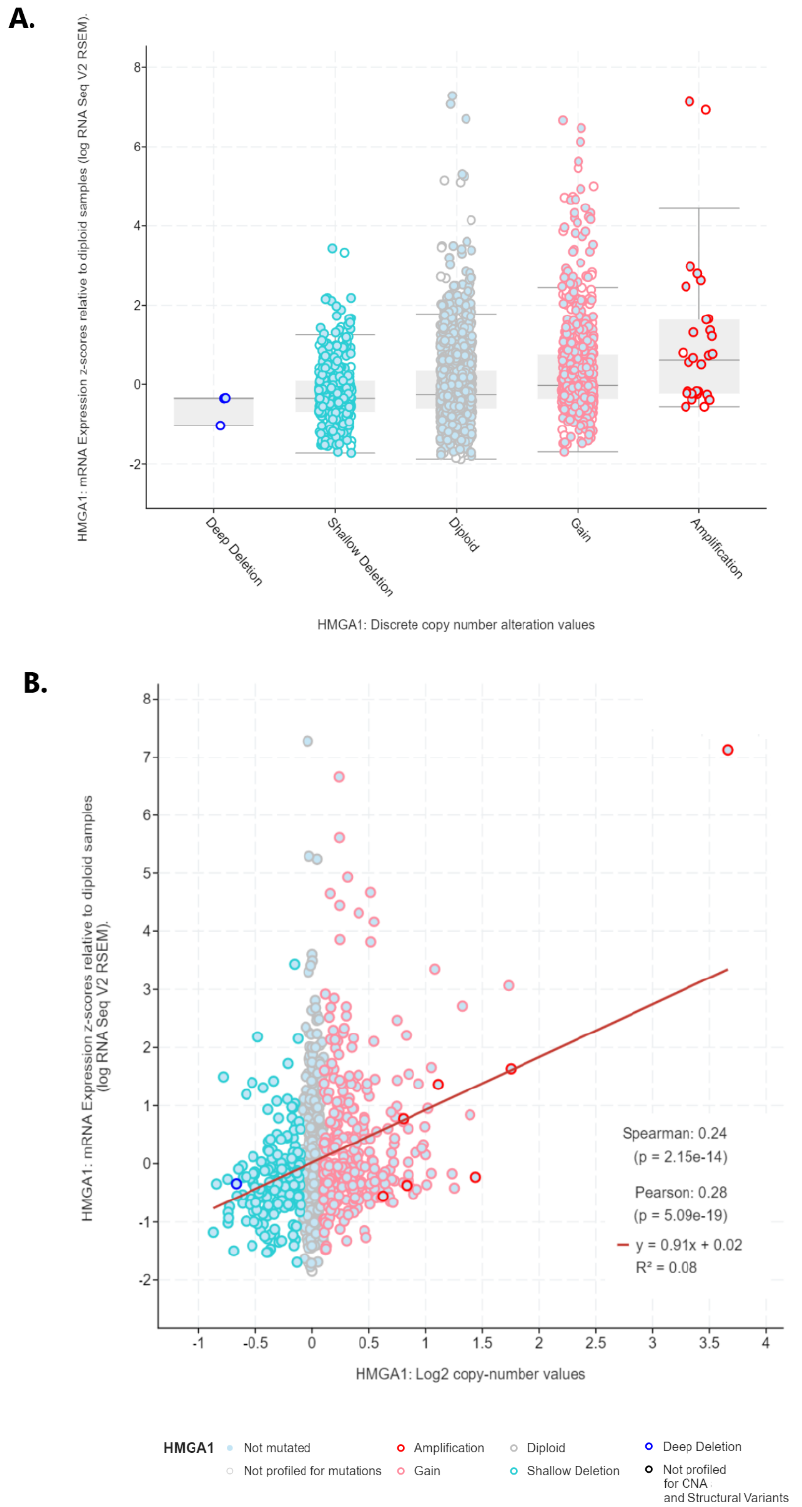
Figure 10. Association between HMGA1 mRNA expression level and ( A ) discrete copy number alterations, ( B ) log2 copy-number value (generated by cBioPortal).